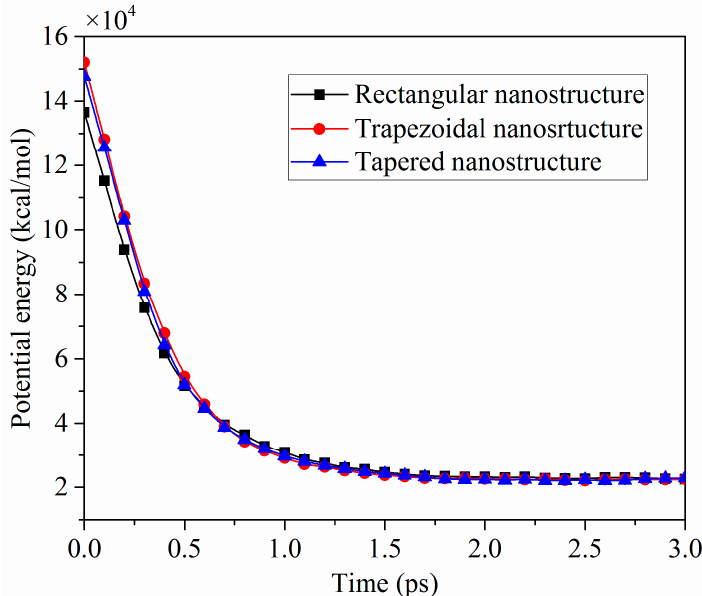
Figure 7. Potential energies of nanostructures with different shapes when the interfacial adhesion energies decreased by 90%.